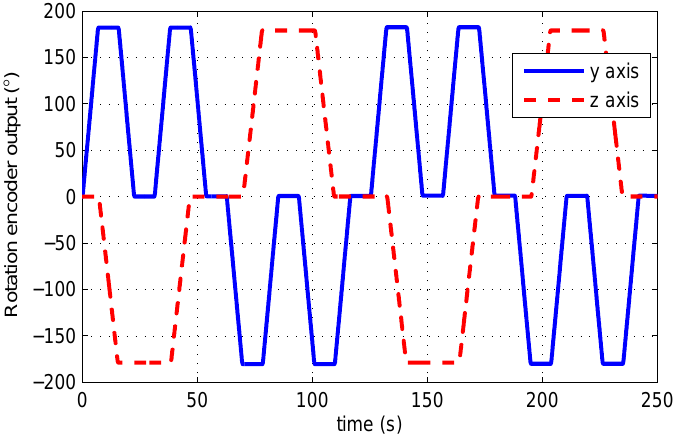
Figure 9. Rotation encoder outputs in two rotation